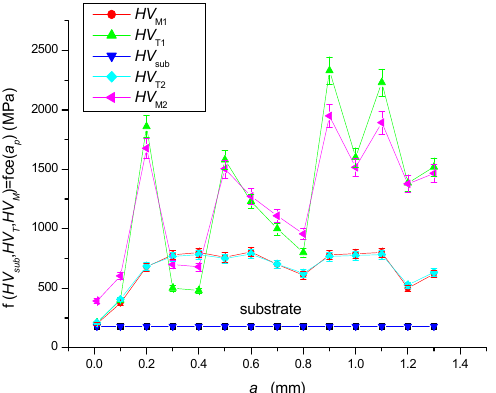
Figure 8. Demonstration of Vickers hardness changes along with the depth of cut of the steel substrate and NiCrBSi/NiCrBSi–WC coatings.